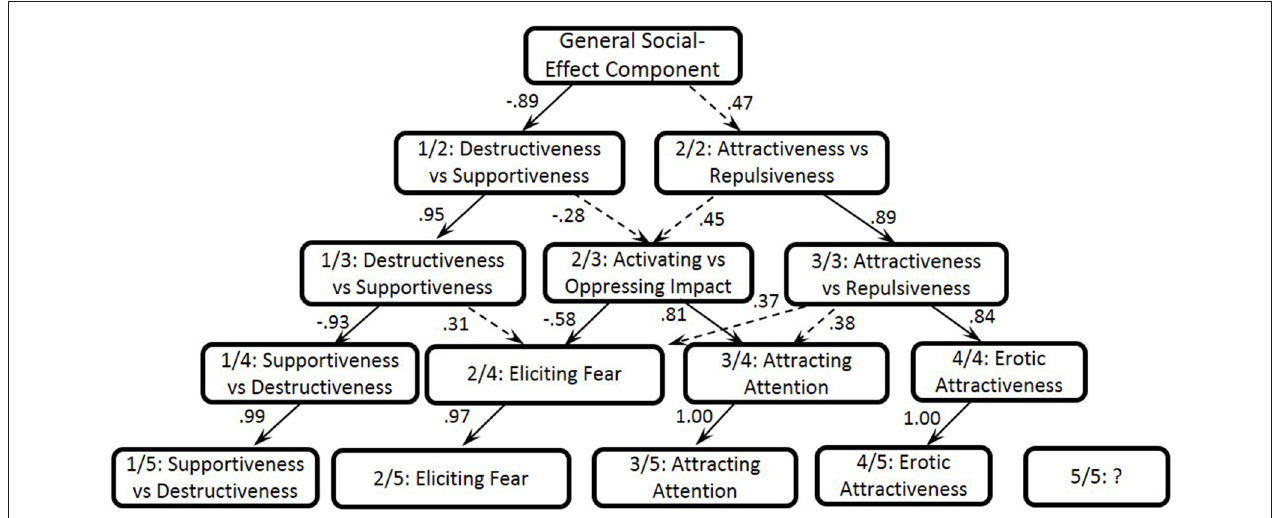
FIGURE 1 | One to five-component hierarchical structure of the social effects based on the observer-rating